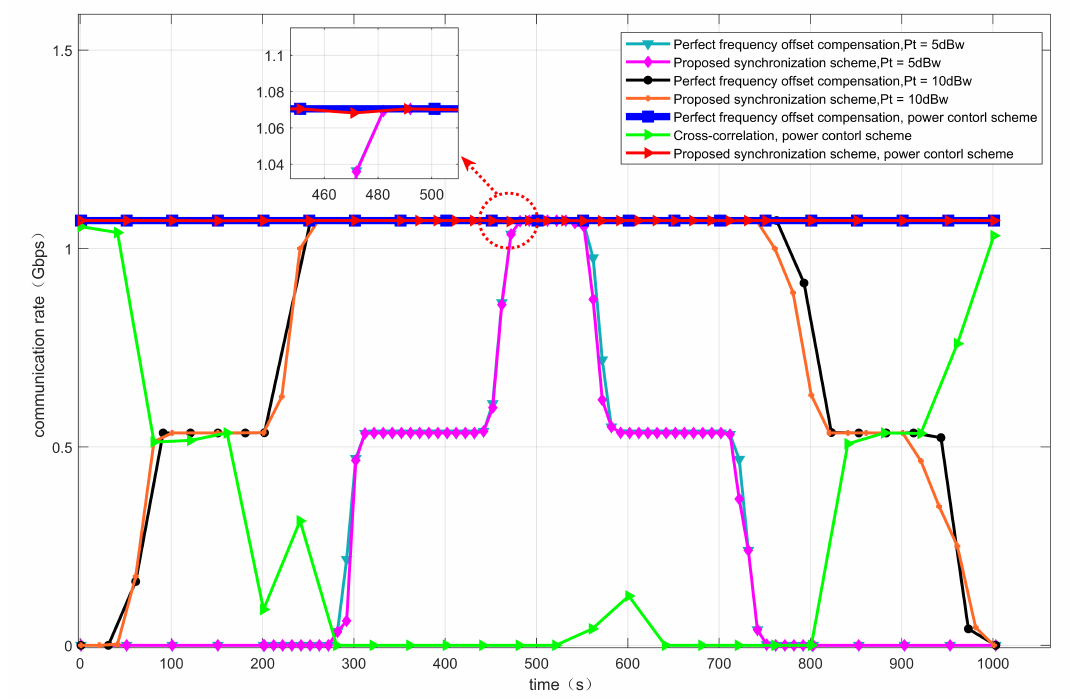
Figure 11. Terminal communication rate with fixed transmit power and power control